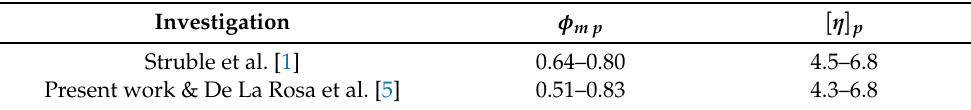
Table 3. Definition domains of the parameters φ m p and [ η ] p